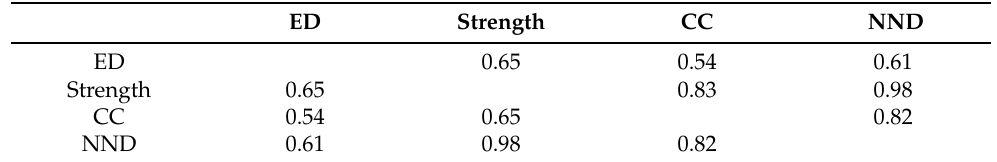
Table 4. Mean correlation between